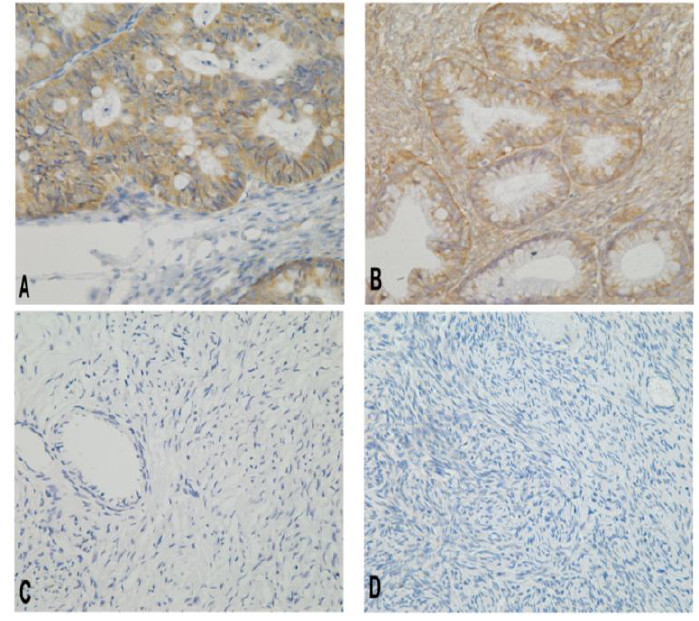
Figure 1. Immunohistochemical micrographs of Beclin 1 protein in different ovarian tissues (400×). The level of Beclin 1 was lower in normal ovarian tissue and benign ovarian epithelial tissue than in ovarian epithelial cancer or borderline ovarian tumor. ( A ) Malignant; ( B ) borderline; ( C ) benign; and ( D ) normal ovarian tissue.